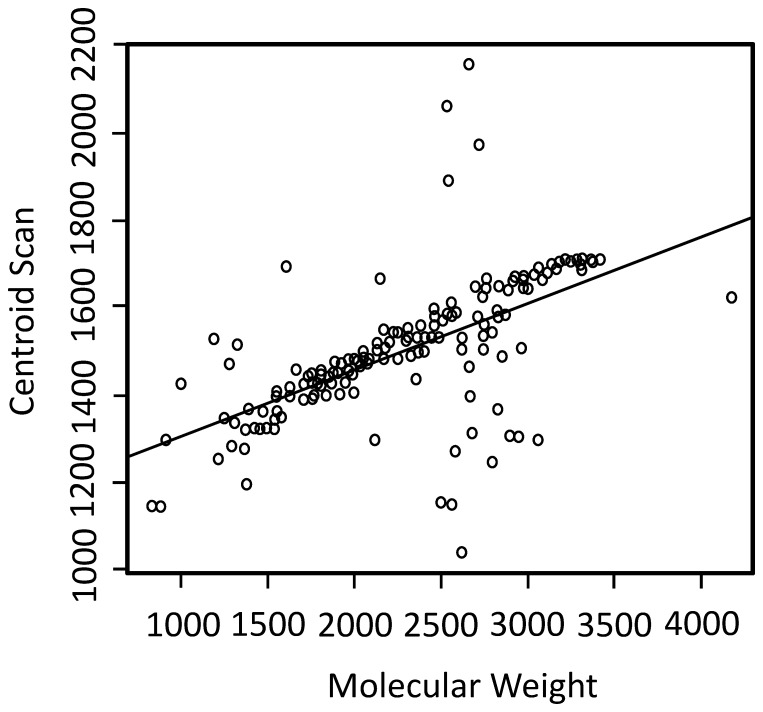
A linear fit of the centroid scan numbers (average elution time point).